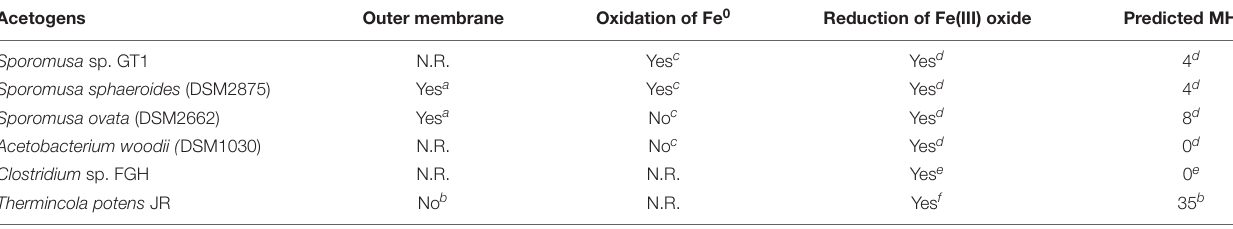
TABLE 1 | Summary of predicted multiheme c -type cytochromes in homoacetogens. Outer